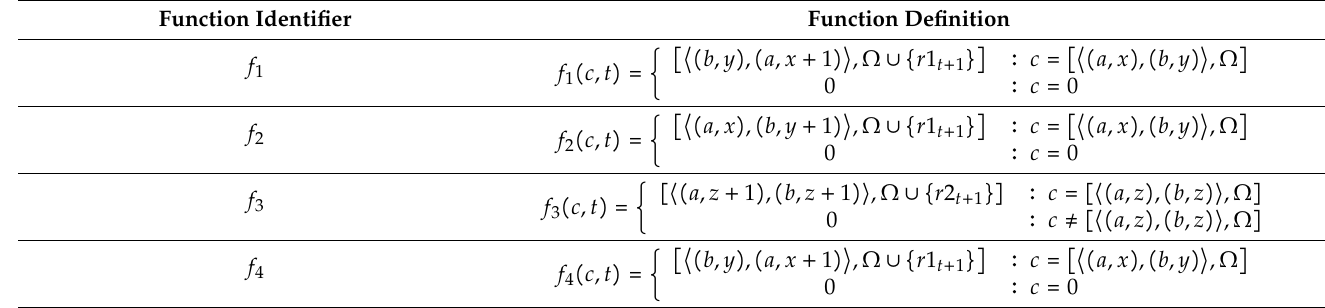
Table 2. Mission progress function definitions for state space presented in Figure 4. All actions defined by reaction rules are assumed to take 1 unit of time. It is worth noting that f 3 function requires both UAVs to be in the same time (variable z ) in order to return something other than